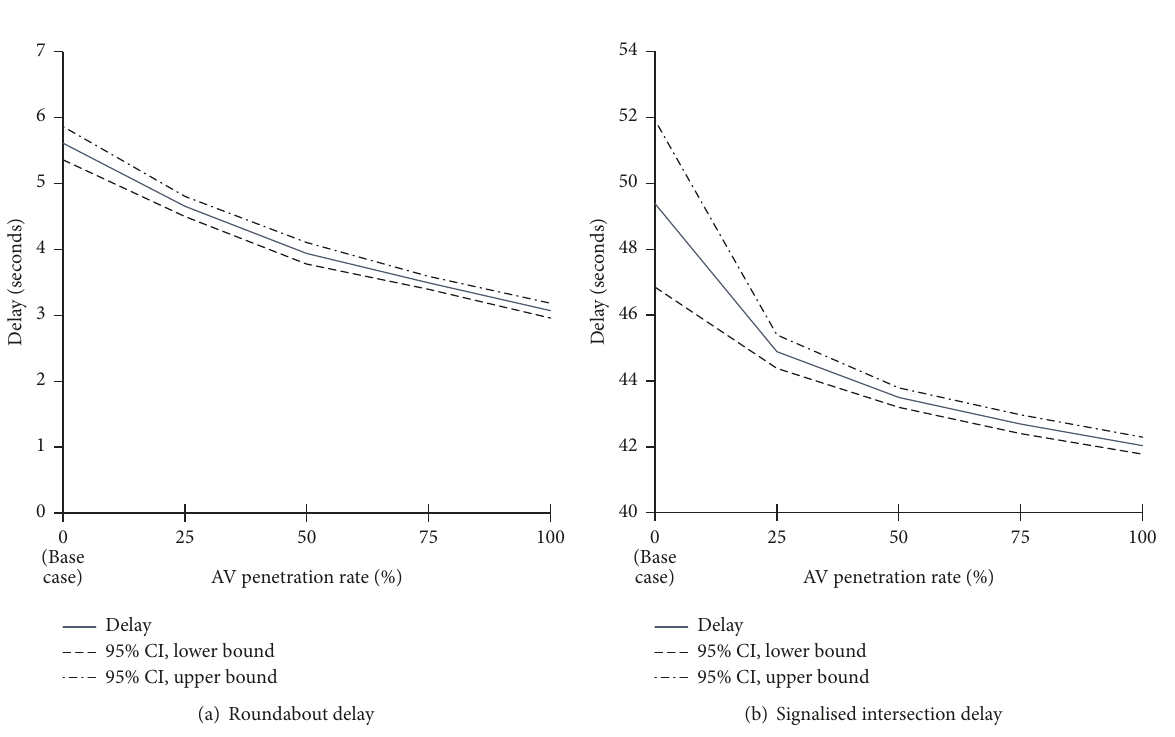
Figure 11: Delay results at an increasing AV penetration